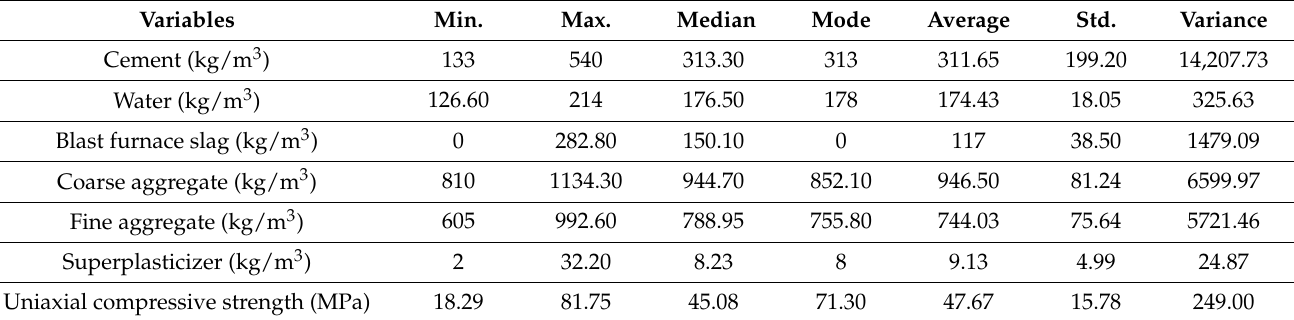
Table 1. Variables data